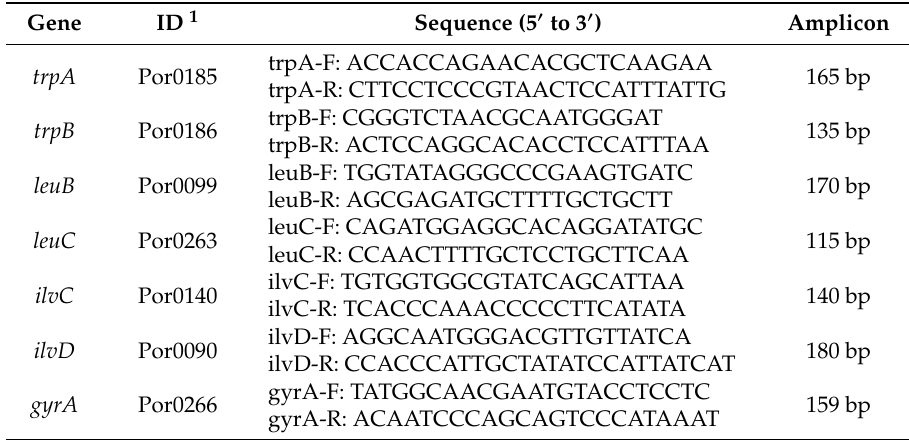
Table 1. Primers used to determine the expression levels of essential amino acid biosynthesis genes of P. aleyrodidarum